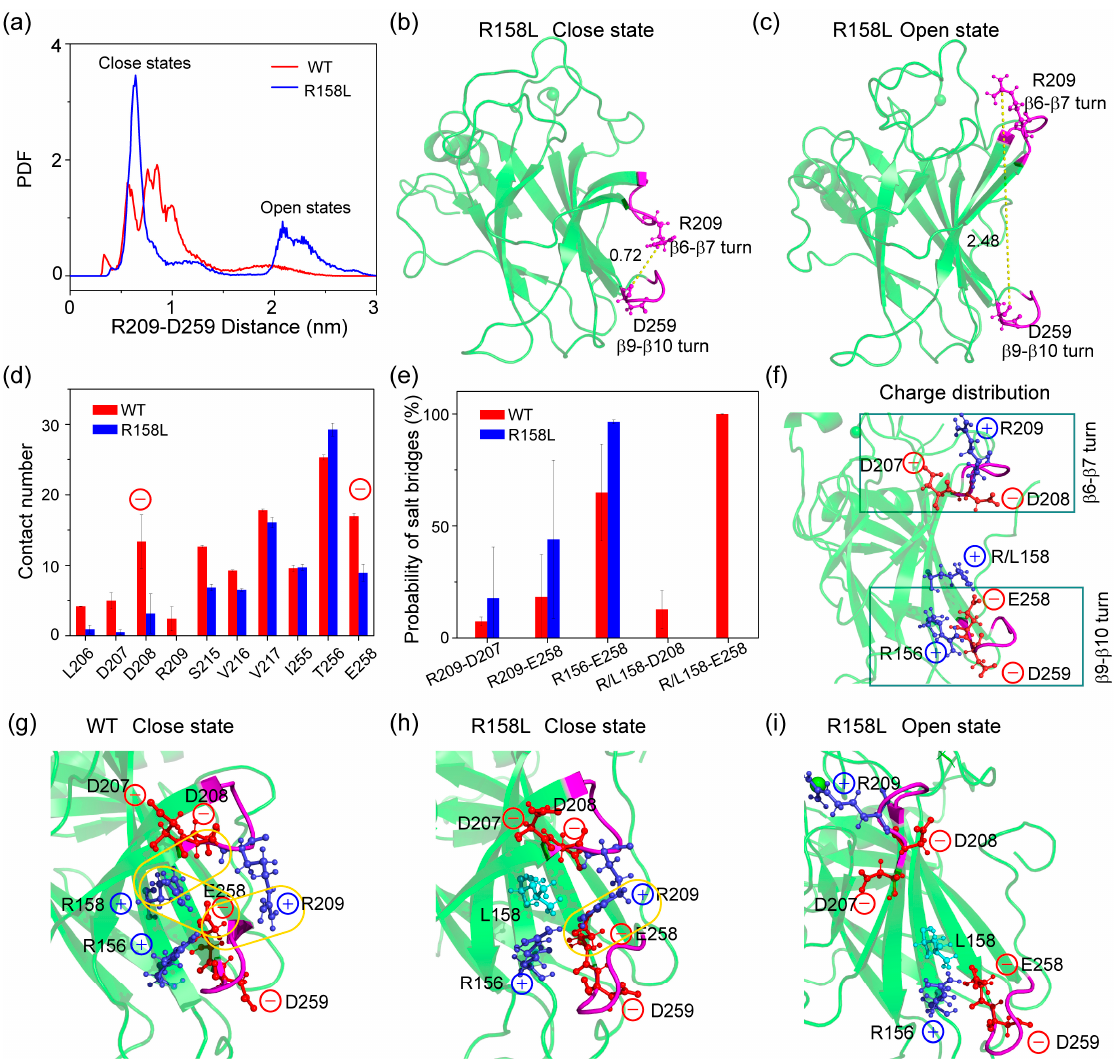
Figure 5. Differential conformational sampling of β 6– β 7 turn in R158L mutant system. ( a ) The distribution of the distance between CZ atom of R209 ( β 6– β 7 turn) and the backbone carbonyl oxygen atom of D259 ( β 9– β 10 turn). The snapshots of ‘close’ ( b ) and ‘open’ ( c ) states from two MDs at 1000 ns. ( d ) The contact number between R158L and nearby amino acids. ( e ) The salt-bridge probabilities ( f ) Initial charge distribution for β 6– β 7 turn and β 9– β 10 turn at WT and R158L mutant system. Charge positively residue R158 plays a key role in the salt-bridge network. ( g ) Salt-bridge network of WT p53C at 1000 ns. Salt-bridge networks of R158L mutant for ‘close’ ( h ) and ‘open’ ( i ) states at 1000